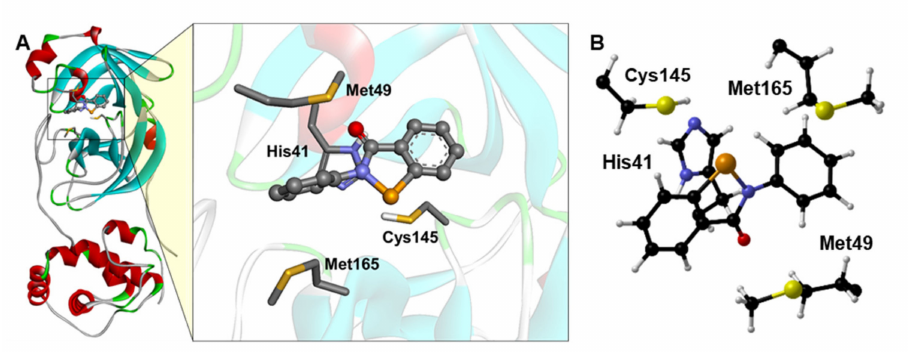
Figure 1. ( A ) Docking simulations between M pro and EbSe. For better visualization, only the side chain of the main residues is shown. ( B ) Optimized M pro cluster, with EbSe docked inside. For clarity, only C α , H α and amino acids side chains are displayed, and it is oriented for optimal view. Level